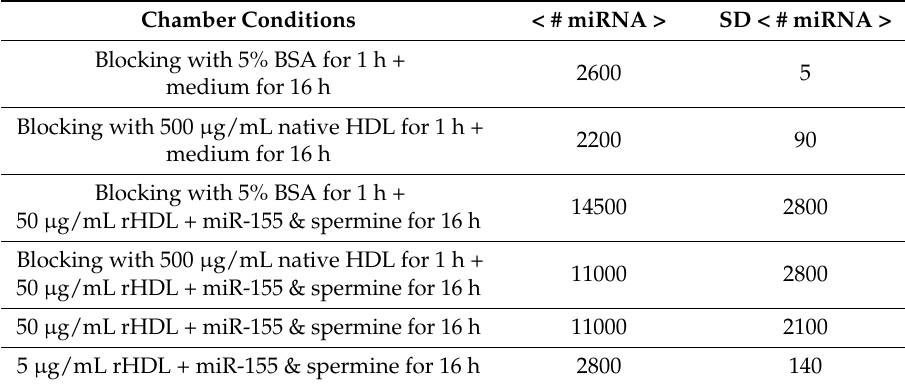
Table A1. Unspecific binding of HDL particles to the chamber.